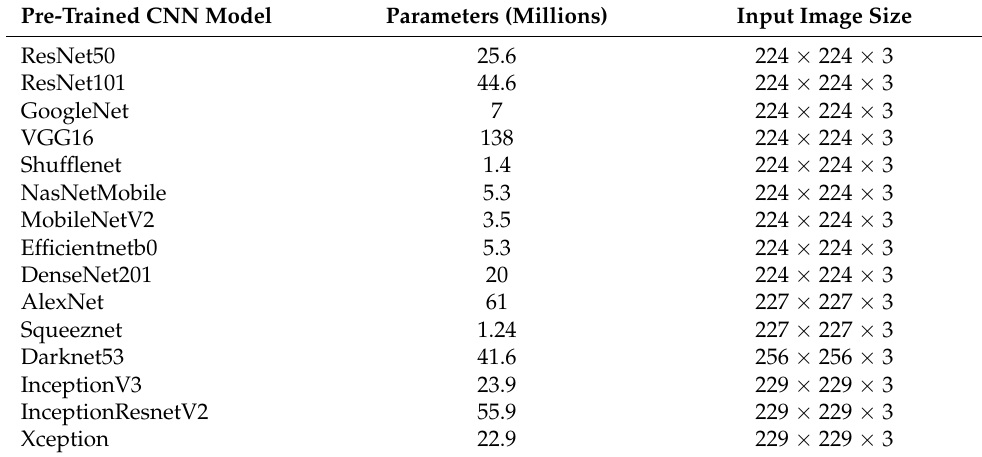
Table 5. Pre-trained models input size.